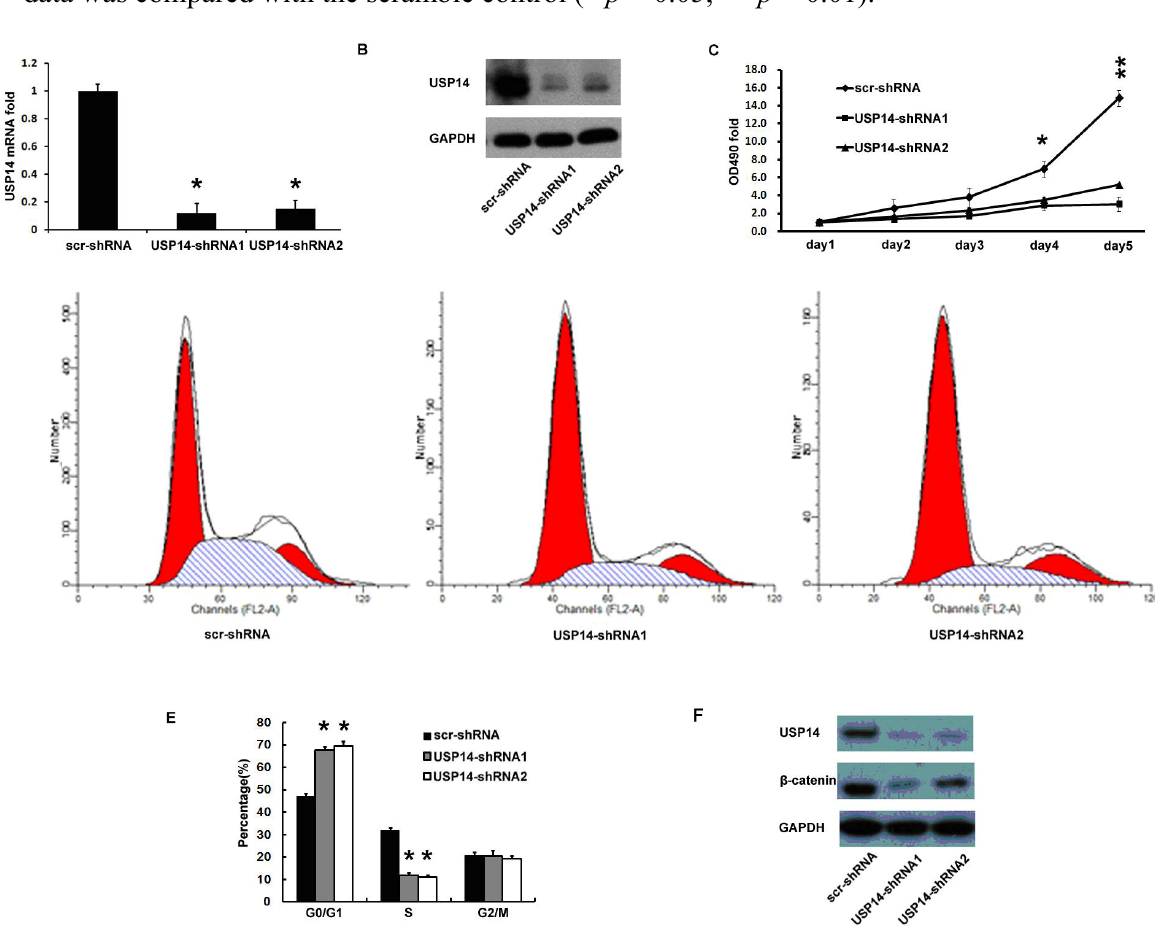
Figure 4. USP14 silencing impaired A549 cell proliferation coupling with β -catenin reduction. ( A ) Real-time qPCR analysis of the knockdown validity for USP14; ( B ) Western blot analysis of the knockdown validity for USP14; ( C ) MTT assay of A549 cell growth curves after transfection with USP14-shRNA lentivirus; ( D ) FACS assay of A549 cell cycle after transfection with USP14-shRNA lentivirus showed that: The cell number in S phase was decreased (in shadow), and the cell number in G0/G1 phase was significantly increased (in red); ( E ) Percent of cells in G0/G1, S and G2/M. Transfection increased the percent of G0/G1 phase cells, and decreased the percent of S phase cells. * p < 0.05; ( F ) Western blot analysis of correlation between USP14 and β -catenin. All the data was compared with the scramble control ( * p < 0.05, ** p <